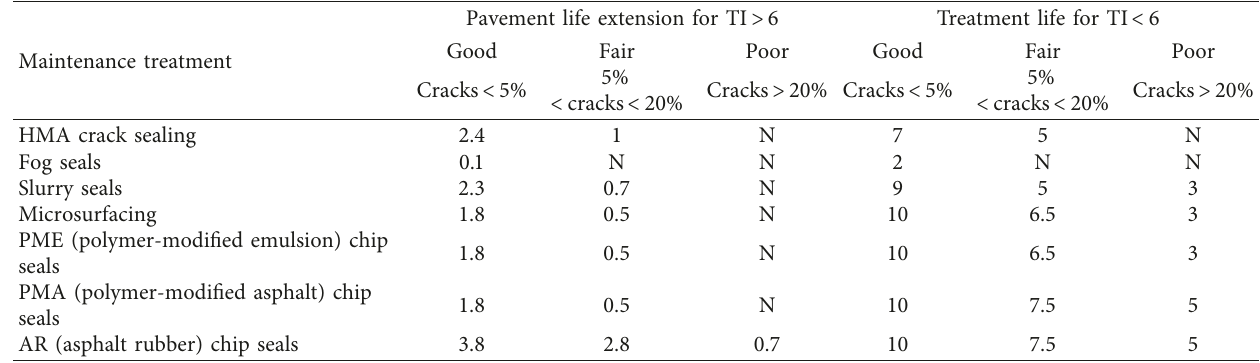
Table 1: Pavement life extension (years).